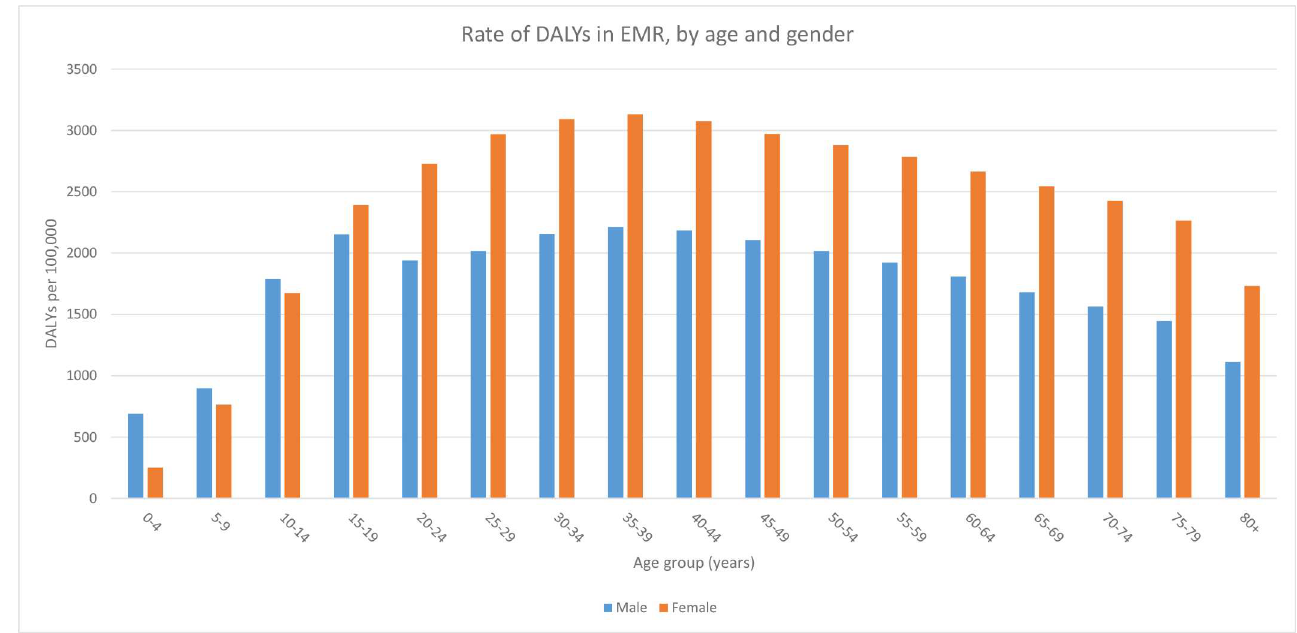
Fig 2. Rate of DALYs in EMR, by age and gender.